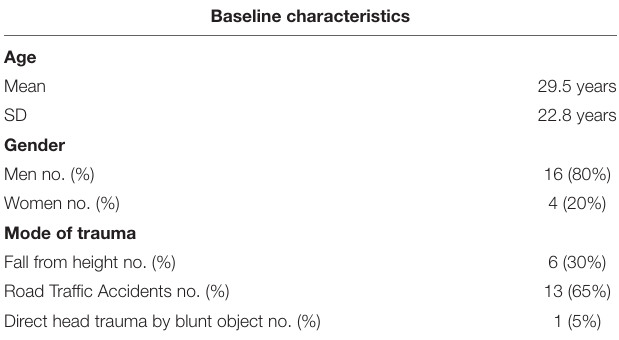
TABLE 1 | Baseline characteristics.